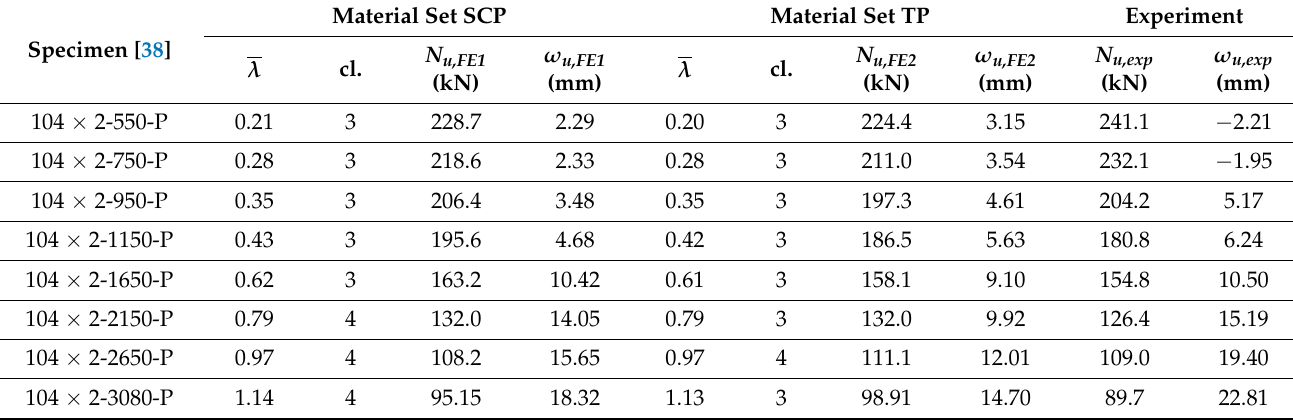
Table 14. Approach #D, FEA and experiment results of the cross-section set 104 × 2 CHS pin-ended columns.